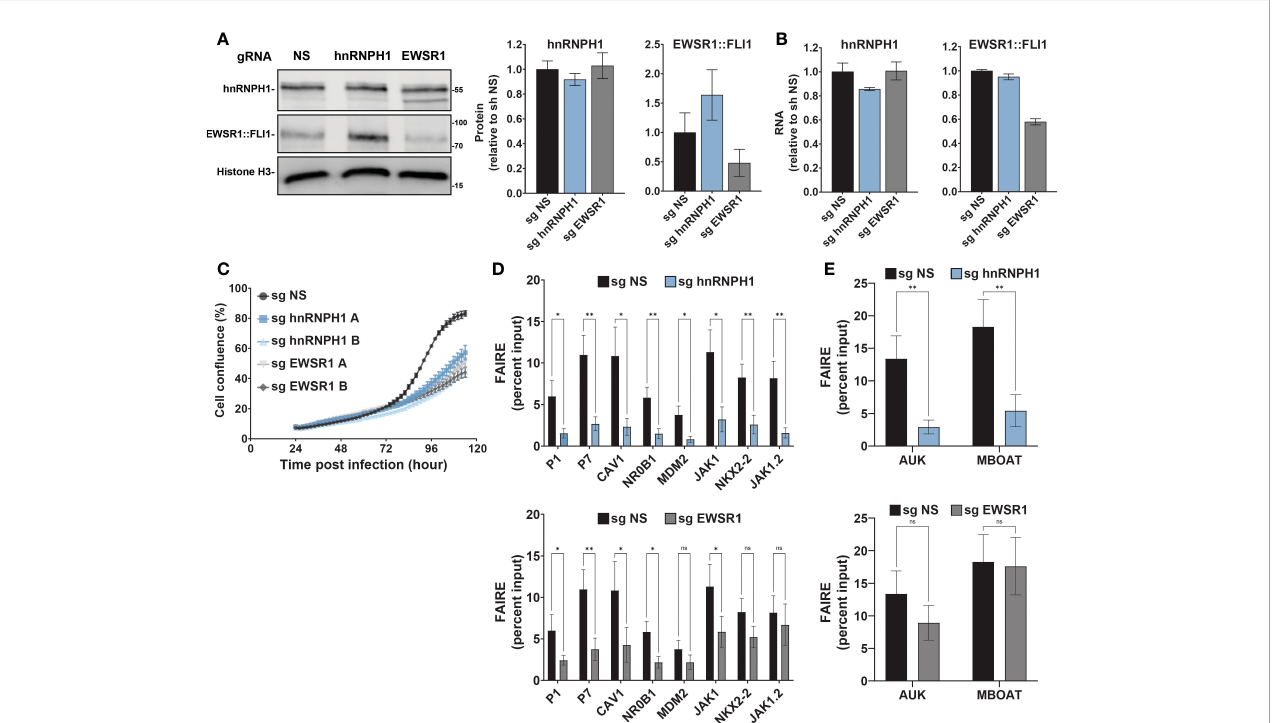
FIGURE 4 hnRNPH1 knockdown recapitulates the effect of MS0621 on Ewing sarcoma cell proliferation and FAIRE-qPCR (A) Western blot analyses of hnRNPH1 and EWSR1::FLI1 protein knockdown in A673-CRISPRi cells. Left: Representative western blots. Right: Quanti fi cation of western blot band intensities